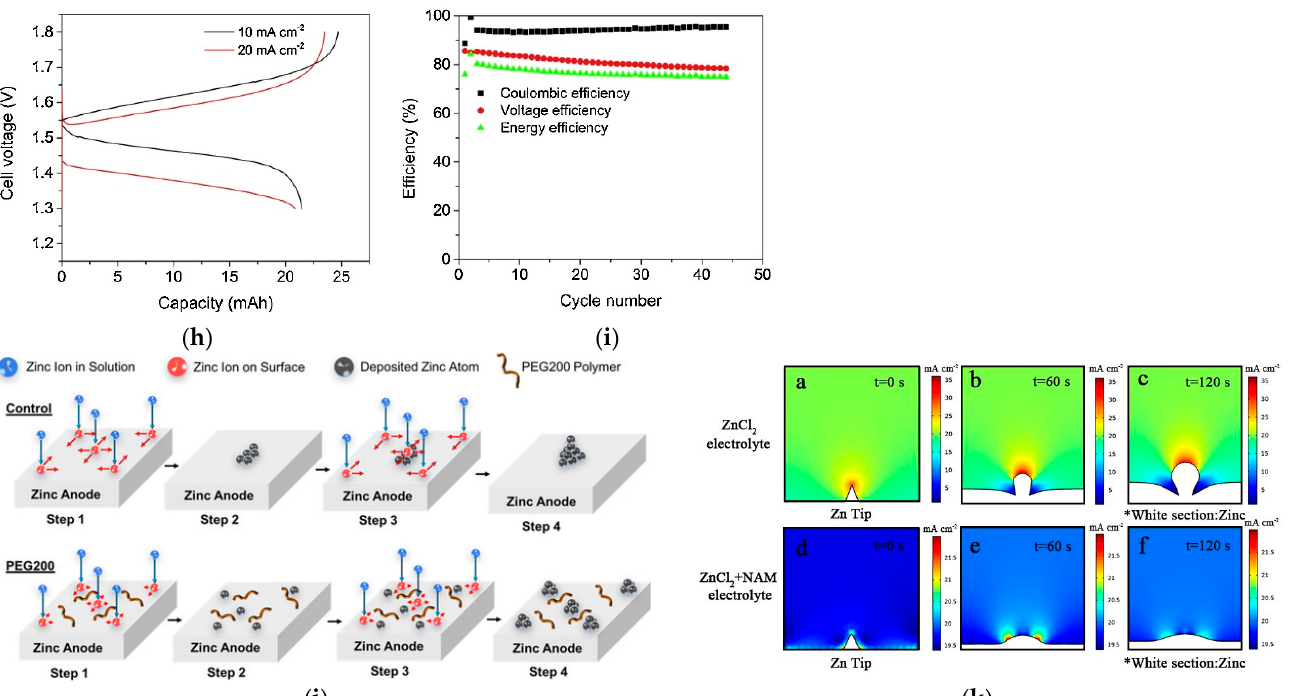
Figure 10. ( a ) SEM images of the Zn electro-deposits obtained at 40 mA cm − 2 and in the electrolyte comprising 3 × 10 − 3 M SnO; reproduced with permission from [98]. Copyright 2015, Elsevier; SEM images of the Zn metal after charge–discharge cycling with various supporting electrolytes: ( b ) deionized water, ( c ) NH 4 Cl (1.0 M), ( e ) CaCl 2 /H 2 O (3.5 m), ( f ) CaCl 2 /H 2 O (3.5 m) + NH 4 Cl (0.5 M); CV curves of ZnCl 2 (10 mM) + NH 4 Cl (x M, x = 0, 0.2, 0.5, 1.0), ( d ) and CaCl 2 /H 2 O (3.5 m) + NH 4 Cl (x M, x = 0, 0.2, 0.5, 1.0) ( g ); ( h ) Charge/discharge cell performance; ( i ) battery efficiencies at 20 mA cm − 2 . Reproduced with permission from [99]. Copyright 2019, Elsevier. ( j ) Schematics of PEG200 electrolytes effecting on Z-P/S process; reproduced with permission from [100]. Copyright 2018, John Wiley and Sons; ( k ) numerical simulations of the Zn 2+ flux distribution at different deposition times. Reproduced with permission from [35]. Copyright 2022, American Chemical Society.